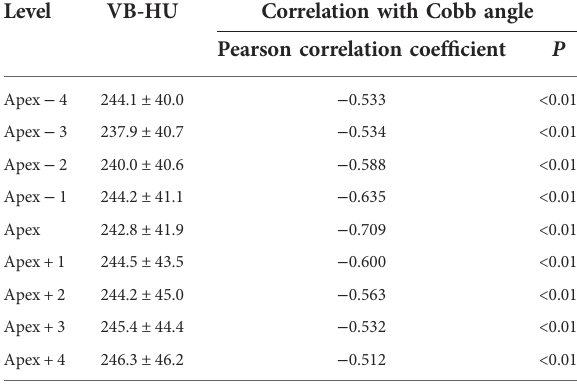
TABLE 2 VB-HU from Apex − 4 to Apex+4 of the major curve and its correlation with Cobb angle. Level VB-HU